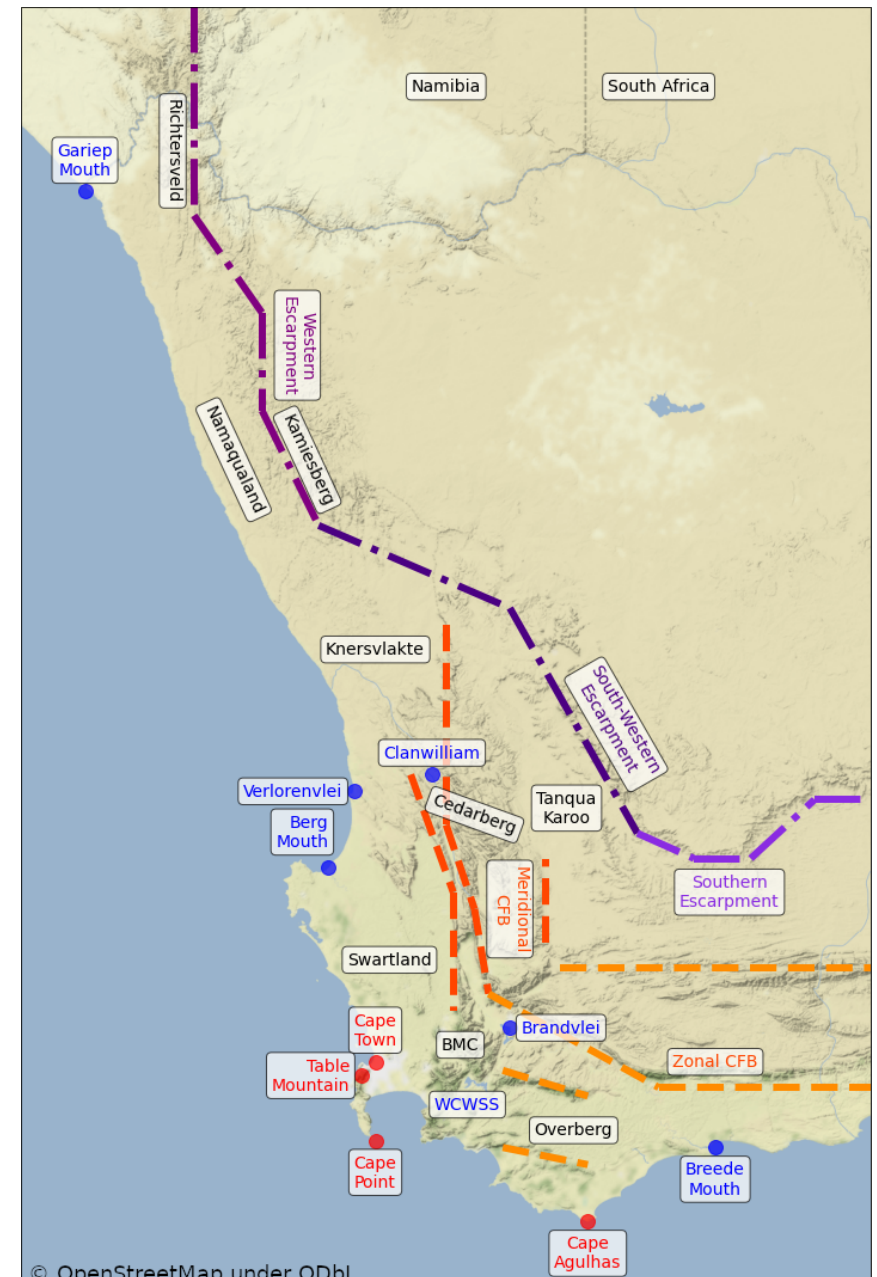
Figure A1. Figure 1 of Conradie et al. (2022): topographic map of the region containing the WRZ. Abbreviations are expanded in Sect. A3. Blue labels are for rivers and reservoirs, red labels for point locations and black labels for regions. Purple lines represent the Great Escarpment and orange lines the Cape Fold Belt (CFB). Map tiles are by Stamen Design (http://stamen.com/, last access: 3 March 2022) under CC-BY 3.0 (http://creativecommons.org/licenses/by/3.0, last access: 3 March 2022) and underlying data © OpenStreetMap (http://openstreetmap.org/, last access: 3 March 2022) under ODbL (http://www.openstreetmap.org/copyright, last access: 3 March